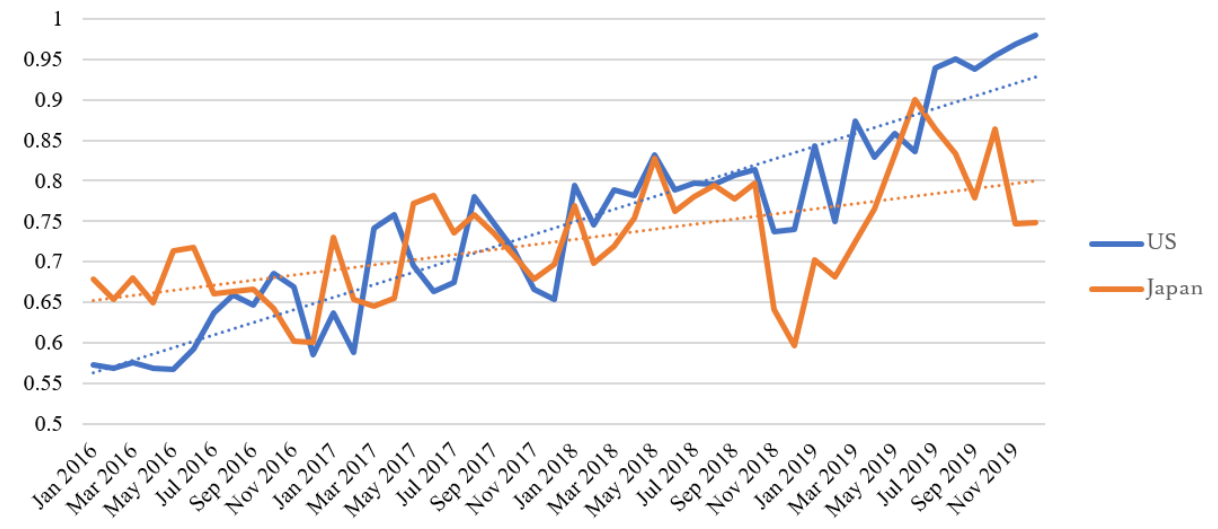
Figure 1. Total number of musculoskeletal-related searches in the United States and Japan (total monthly search volume of the top 20 search queries). Vertical axis: Searches per 100